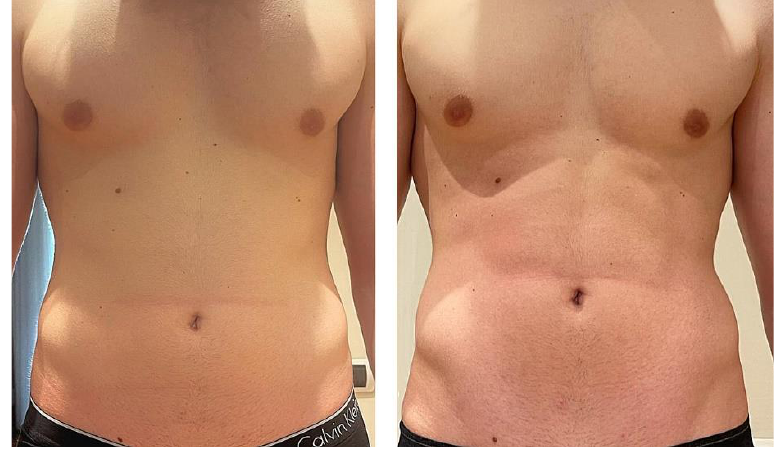
Figure 3. Abdominal frontal view of a male patient before and 1 month after treatment. A visible improvement in muscle tone can be observed.